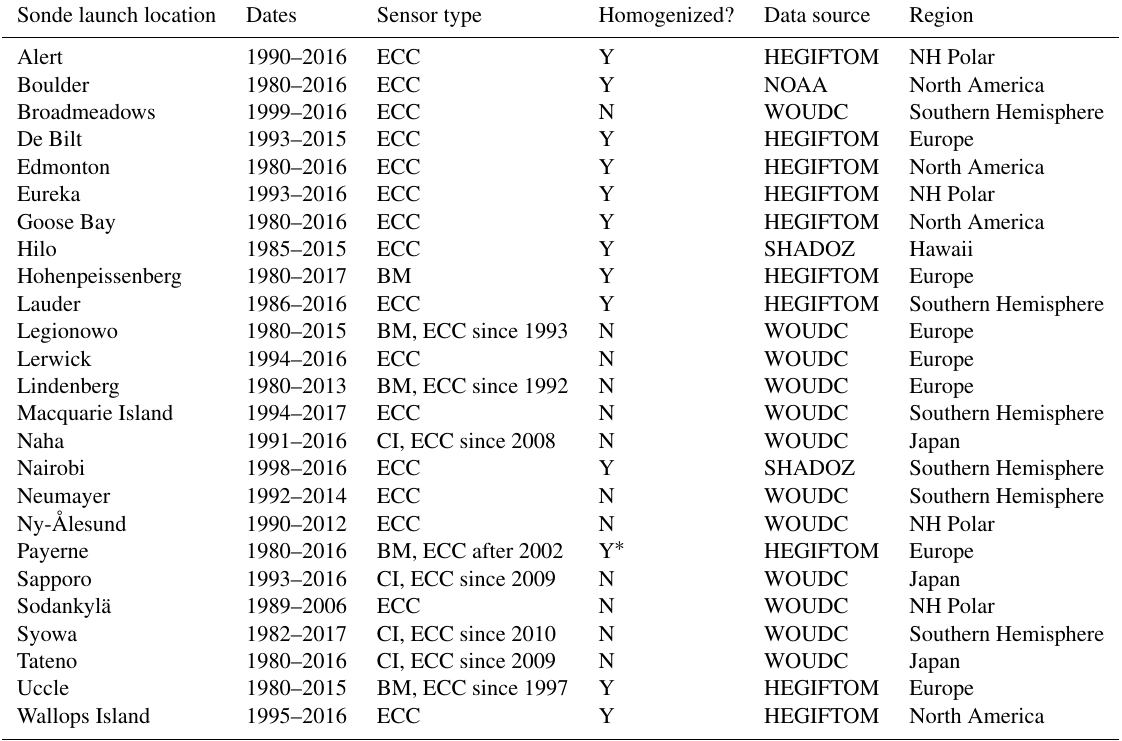
Table 1. Summary of all ozonesonde launch locations, dates, sensor types, data source, and region. Also included is whether each site has been